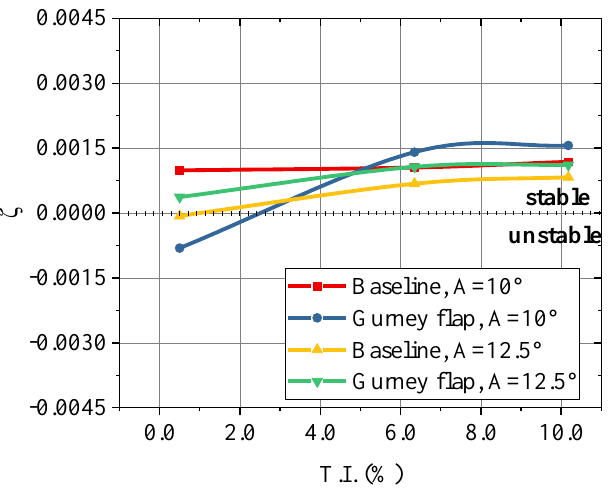
Figure 11. Damping factor at different turbulent inflow.